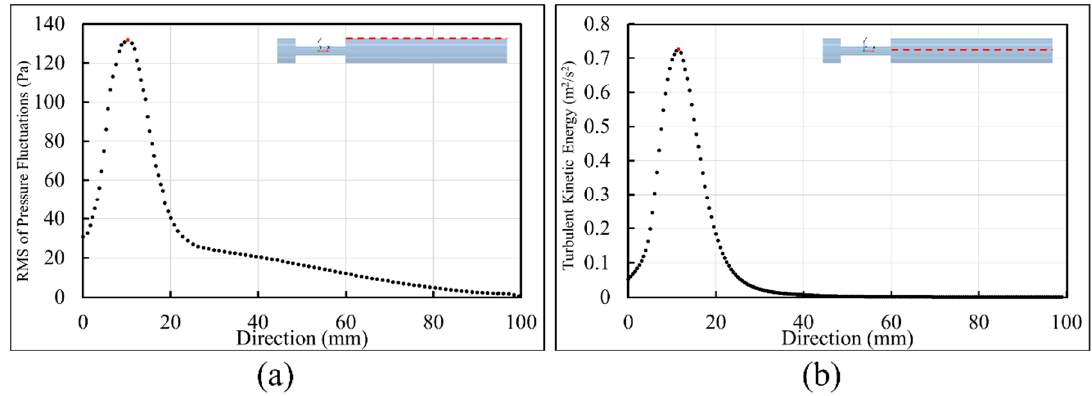
Figure 8. Point of maximum excitation in the post-stenotic region by analyzing ( a ) the RMS of the pressure fluctuations on the wall and ( b ) TKE on the stenosis